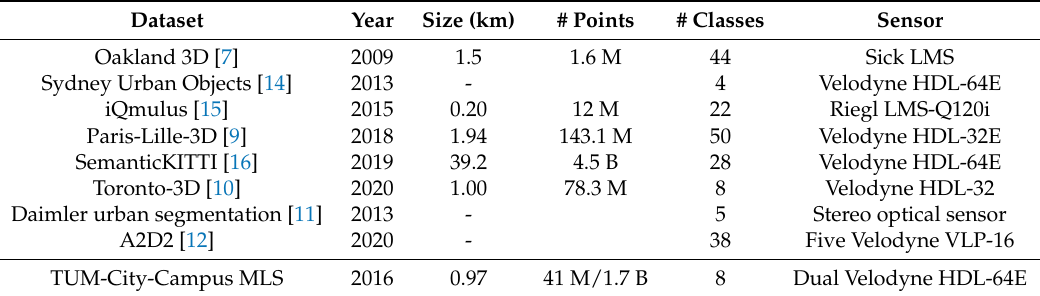
Table 1. Representative MLS point cloud datasets for semantic